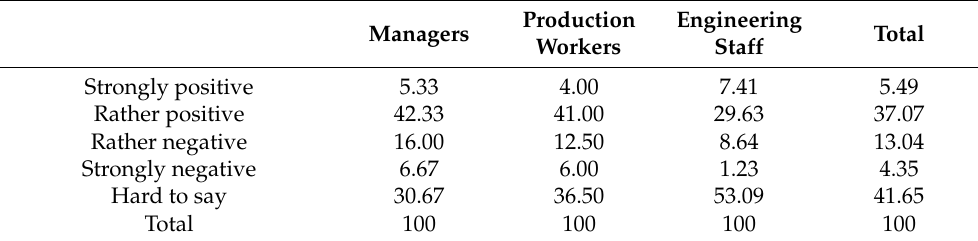
Table 11. Declared attitudes towards automation in the workplace vs. position in % (N =